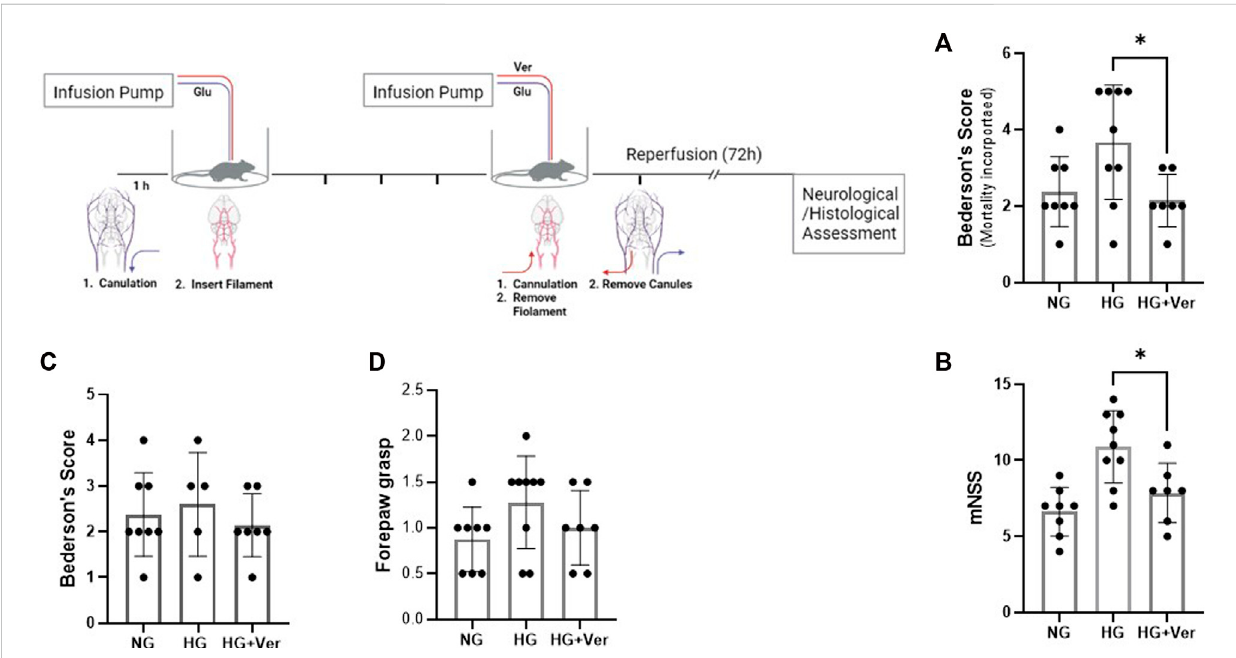
FIGURE 4 Intra-arterial verapamil attenuates neurological de fi cits in a preclinical model of thrombectomy in hyperglycemic stroke. Adult male mice were subjectedto 4 hintraluminal MCAO. Hyperglycemia was established with intravenous glucose infusion starting from occlusion time till 1 h post- fi lament withdrawal. Glucose infusion (25%, 40 µL/h) lasted one more hour after blood fl ow restoration, along with intra-arterial (i.a.) verapamil infusion. Hyperglycemic stroke mice represented lower Bederson ’ s scores (A) and mNSS (B) when treated with i.a. verapamil (0.5 mg/kg, 40 µL/h, 1 h). The animals also showed a trend toward lower Bederson ’ s score after excluding stroke-induced deaths (C) . The scores obtained in forepaw grasp also showed a tendency toward milder functional de fi cits (D) . MCAO, middle cerebral artery occlusion; Ver, verapamil; Glu, glucose; HG, hyperglycemic; NG, normoglycemic; mNSS, modi fi ed neurological severity score. All values are presented as mean ± SEM ( n = 7 – 9); * p <